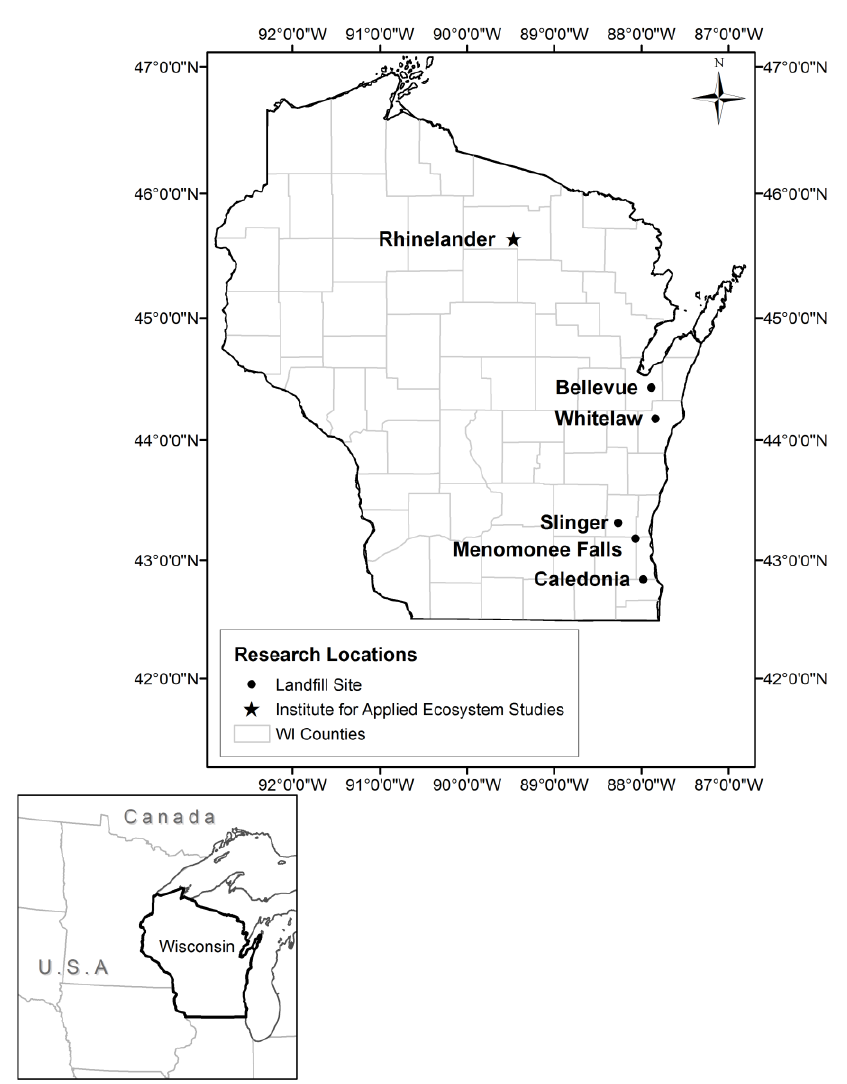
Figure 1. Locations of the five landfill sites where soil was collected and the